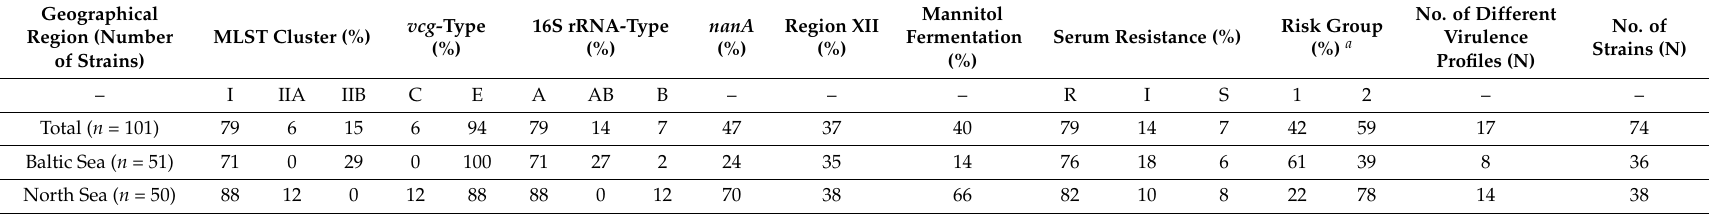
Table 1. Distribution of MLST clusters and virulence-associated traits and genotypes among V. vulnificus isolates from the Baltic Sea and the North